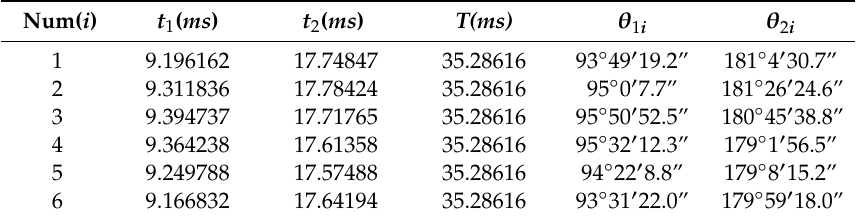
Table 2. The scan time of the two laser planes from initial position to six